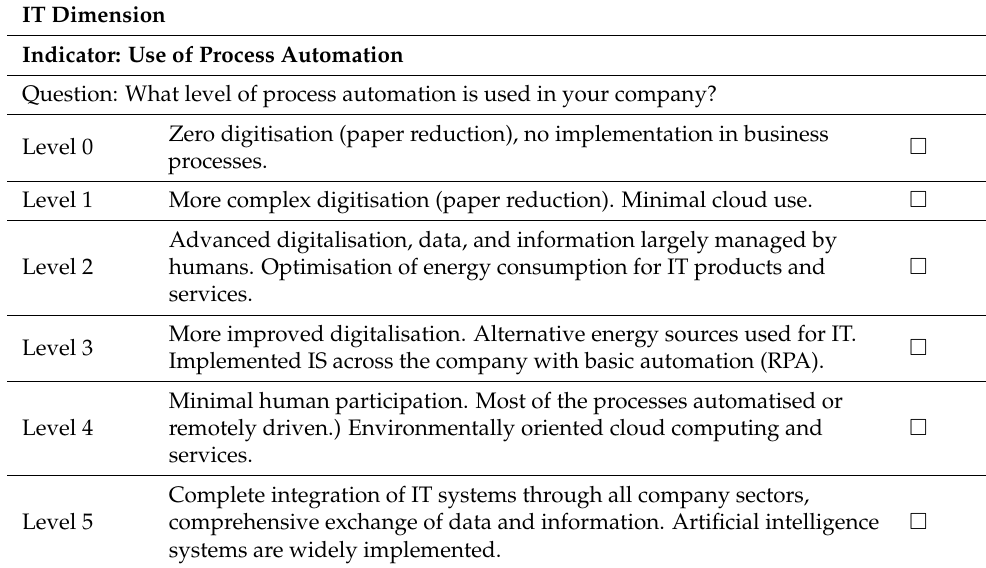
Table A4. An example of a question for evaluating the IT